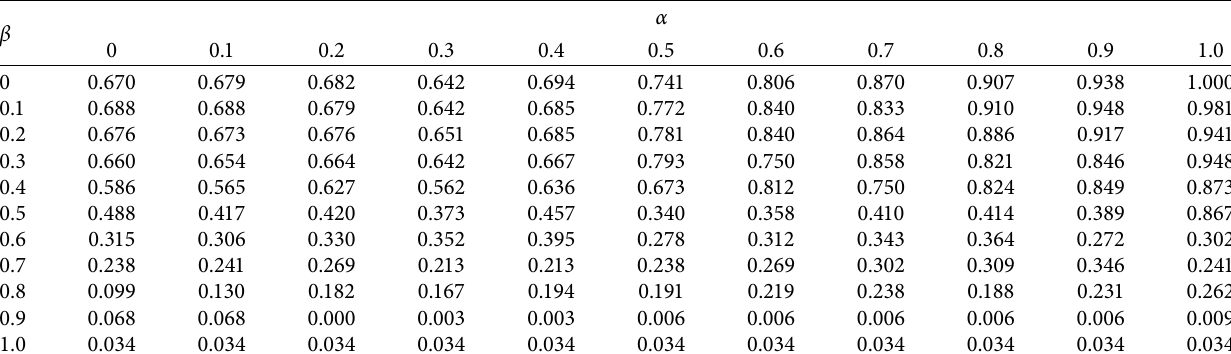
Table 10: Normalization of average travel